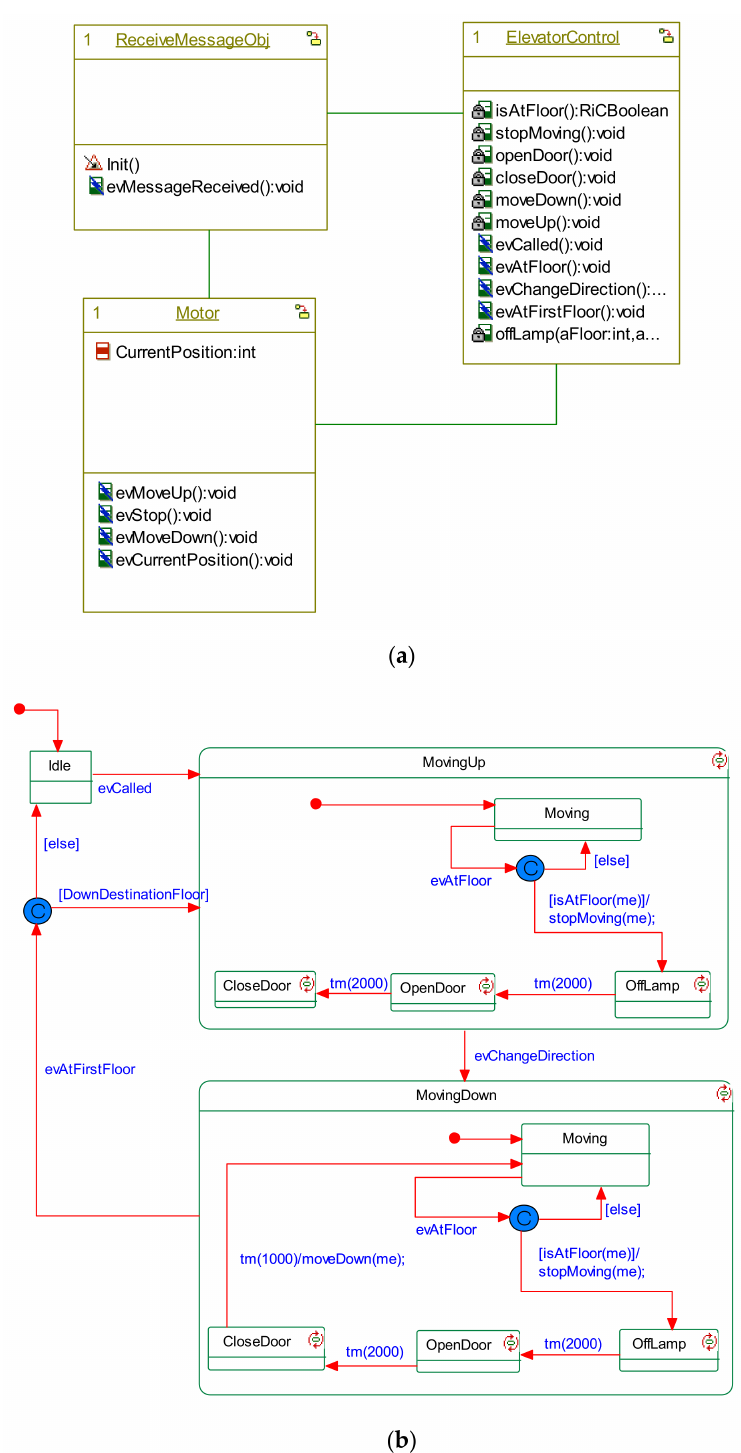
Figure 8. Object Model Diagram and state chart for the elevator controller project: ( a ) Object Model Diagram of the elevator controller project; ( b ) State chart for the ElevatorControl